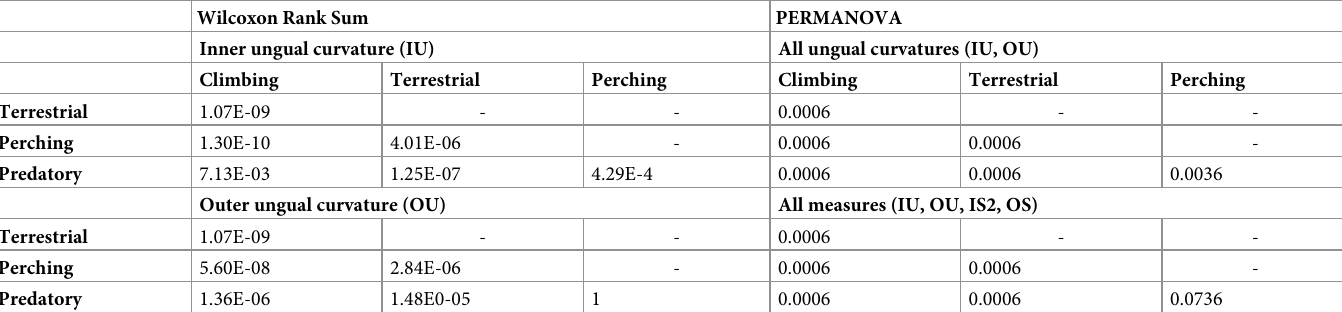
Table 2. Results of non-parametric tests performed on subsets of the avian data. P-values represent Bonferroni-corrected values. Wilcoxon Rank